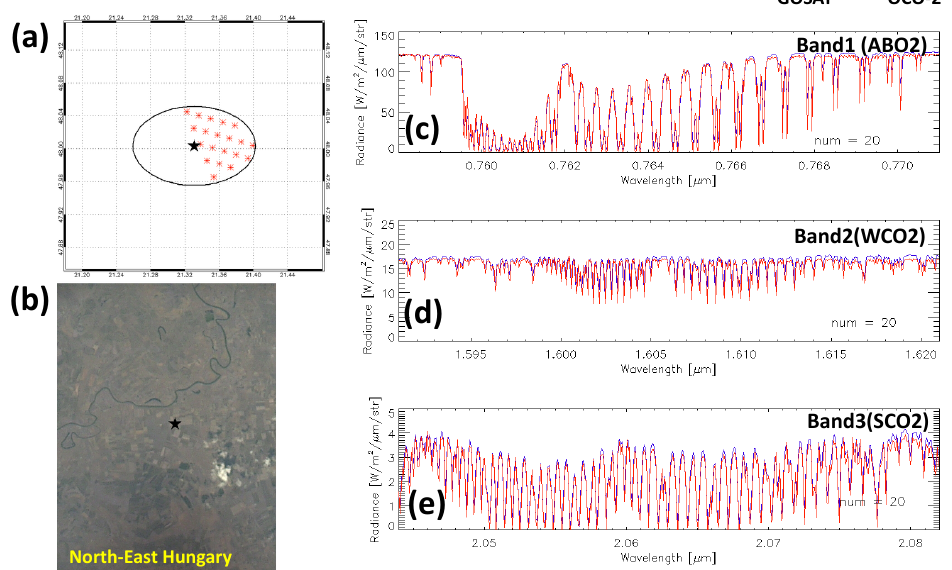
Figure A2. The spectral comparison between glint GOSAT and glint OCO-2 over a farm area in North-East Hungary at 48.0° N, 21.33° E on 9 June 2015 with GOSAT high gain. The plots are same as Figure A1.